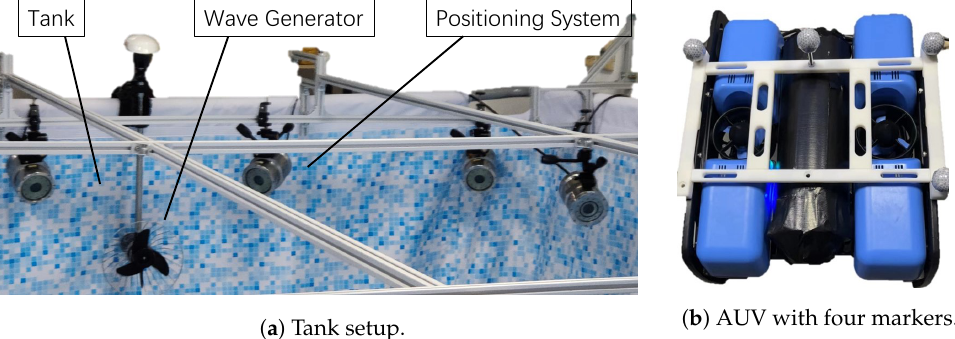
Figure 8. Testbed description: tank, wave generator, positioning system, and AUV with markers.